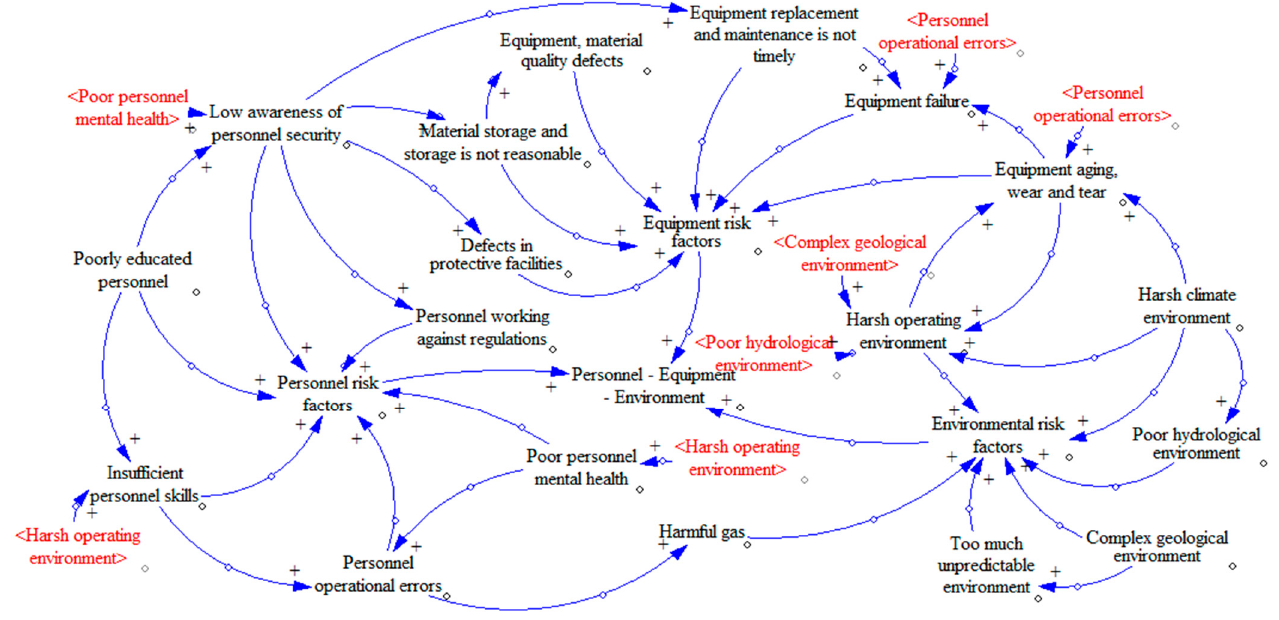
Figure 6. “Personnel–equipment–environment” coupling SD causality diagram.